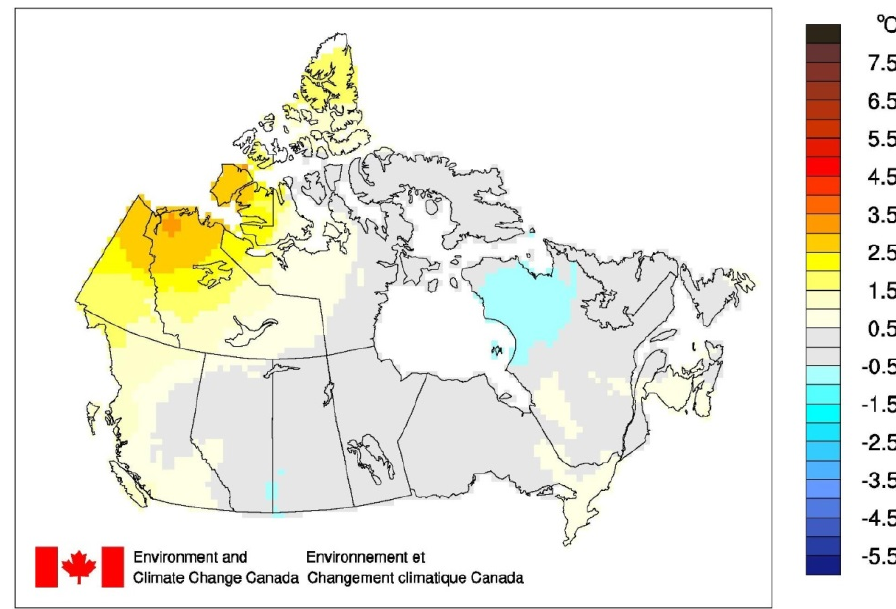
Figure 3. Spatial distribution of temperature departures for 2018 from the 1961–1990 average [2].